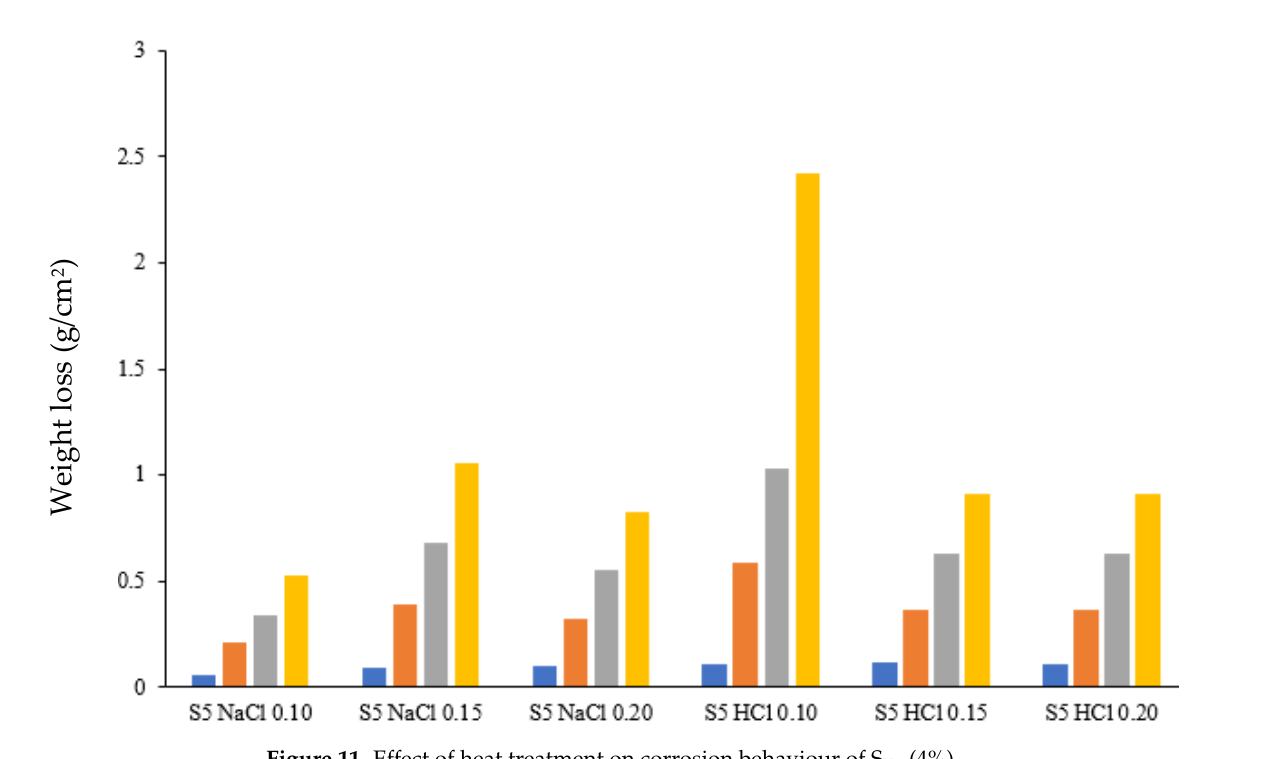
Figure 10. Effect of heat treatment on corrosion behaviour of S T4 (2%).